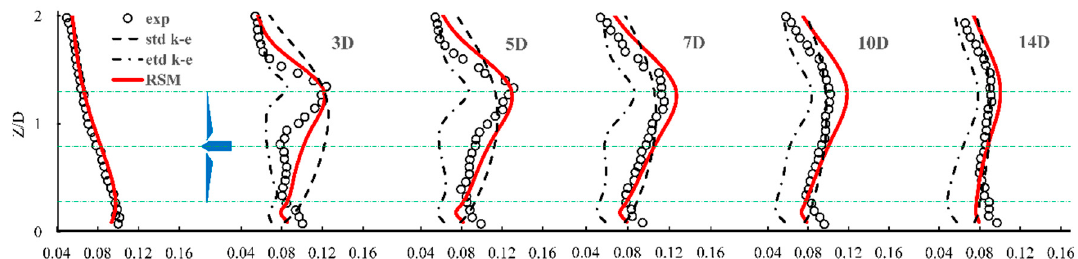
Figure 10. Vertical distribution of stream ‐ wise turbulence intensity obtained from: standard k ‐ε model (std k ‐ e), extended k ‐ε model (etd k ‐ e) RSM and wind tunnel experiments (exp. data obtained from Wu [40]).